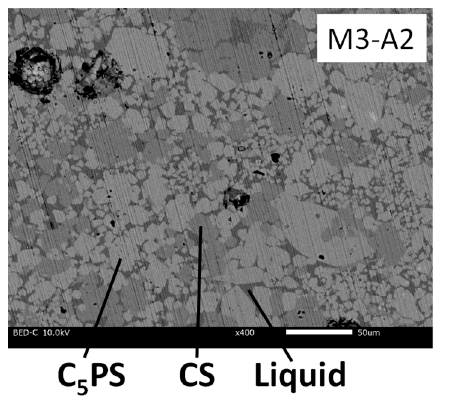
Figure 6. SEM image of M3-A2 (2mass% Al 2 O 3 ) ( left ) and phase composition projected on an isothermal section of the CaO-SiO 2 -P 2 O 5 ternary phase diagram at 1573 K ( right